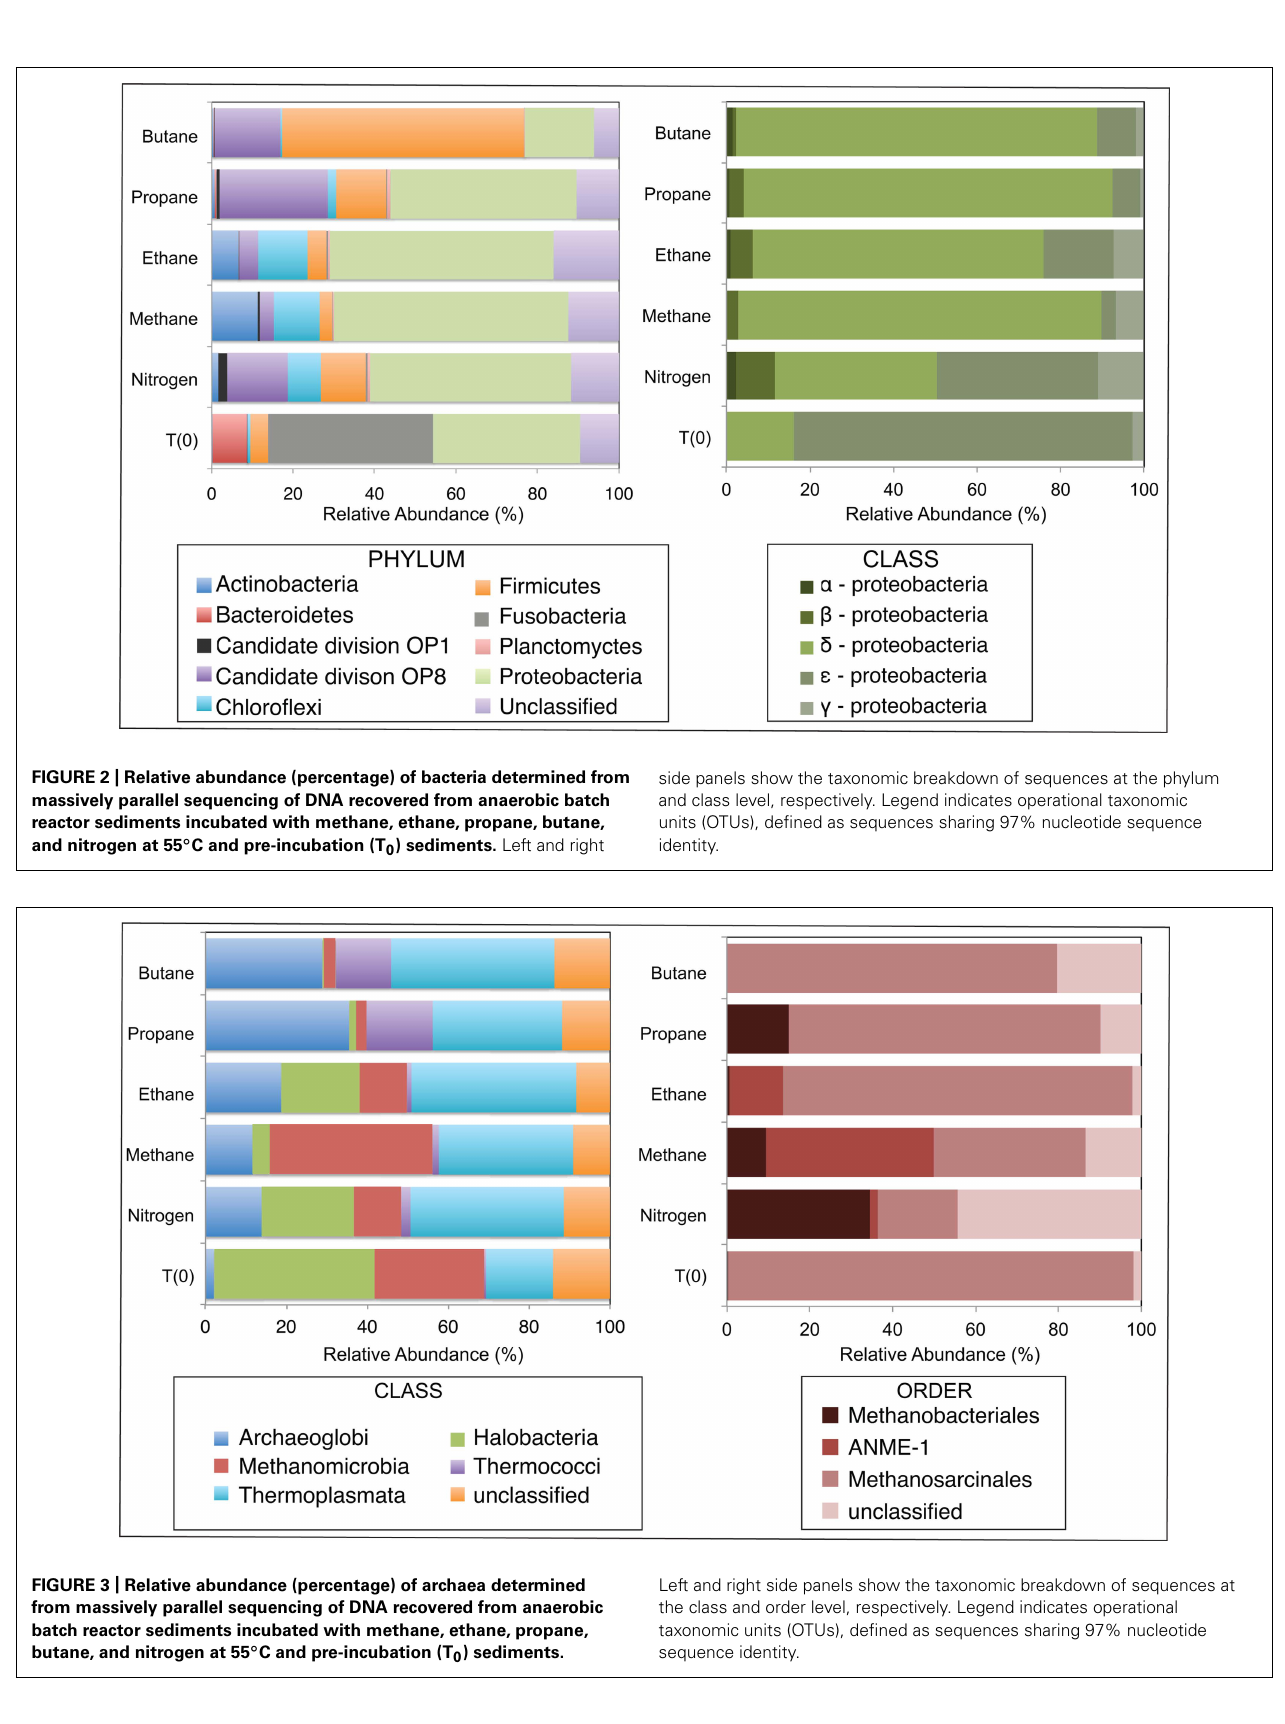
FIGURE 3 | Relative abundance (percentage) of archaea determined from massively parallel sequencing of DNA recovered from anaerobic batch reactor sediments incubated with methane, ethane, propane, butane, and nitrogen at 55 ◦ C and pre-incubation (T 0 ) sediments.